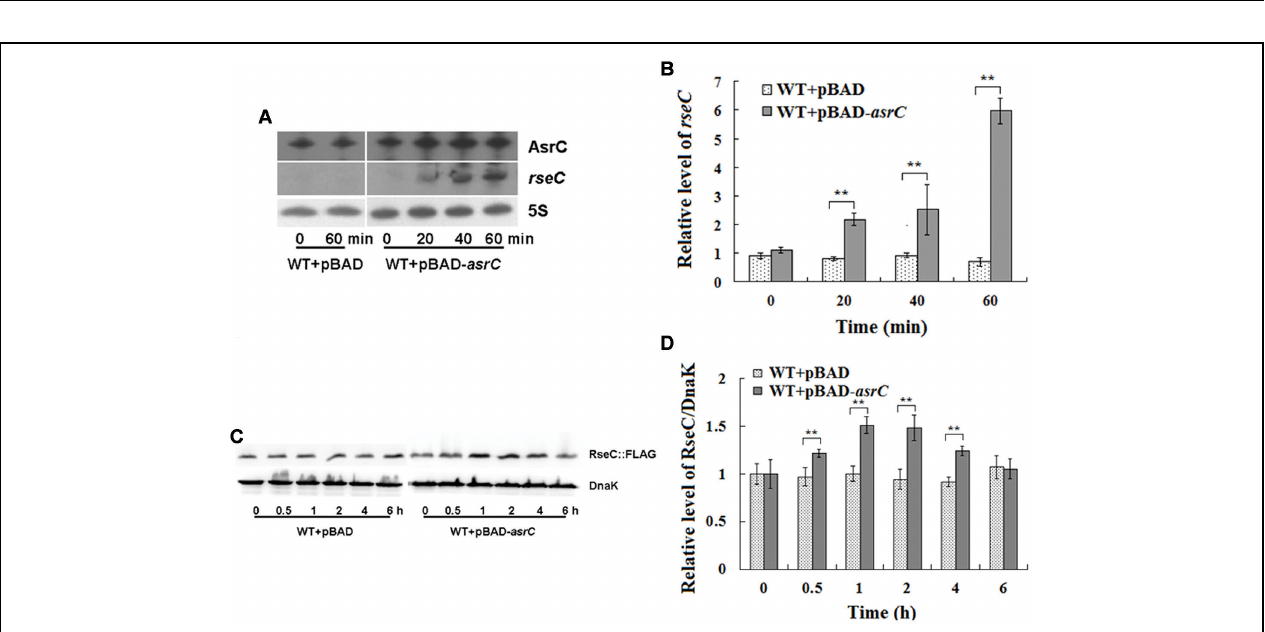
FIGURE 5 | Overexpression of AsrC increased rseC mRNA and protein expression levels. mRNA levels of resC were assessed by Northern hybridization (A) and qRT-PCR (B) . Total RNA from wild-type (WT + pBAD) and overexpression strain (WT + pBAD- asrC ) grown to OD 600 0.4 at 0, 20, 40, and 60 min after addition of L-arabinose (0.2% final concentration). Levels of 5S rRNA were the internal reference. (C) Western blot profile of RseC protein relative to DnaK in WT + pBAD and WT + pBAD-asrC strains. Representative blots are shown. (D) Quantitation of RseC protein based on Western blots. Proteins were isolated from WT + pBAD and WT + pBAD- asrC strains grown to OD 600 0.4 at 0, 0.5, 1, 2, 4, and 6 h after addition of L -arabinose (0.2% final concentration). Experiments were repeated three times and error bars indicate standard deviations. ∗∗ P < 0.01 compared with control group.